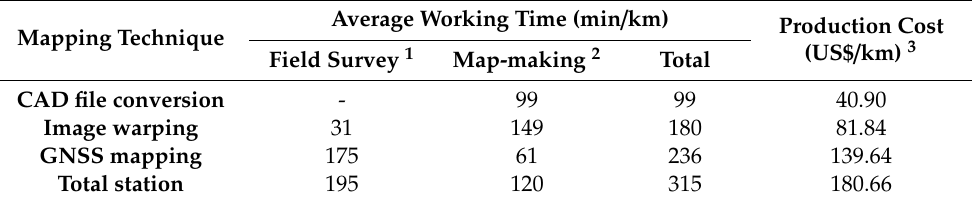
Table 6. Time study and cost analysis of forest road digital map by three mapping